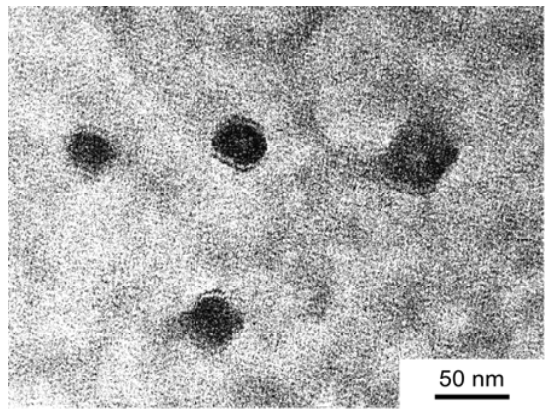
Figure 5. TEM image of PIC micelles with f + = 0.5 at C p = 1.0 g/L in 0.1 M aqueous NaCl.